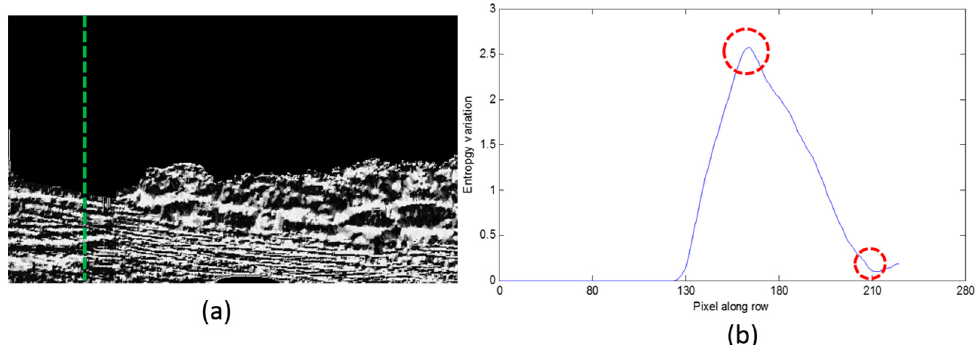
Figure 8. The entropy differential curve when two areas exist. ( a ) The LBP image where the calculation position is shown with the green dashed line; ( b ) The entropy differential curve.